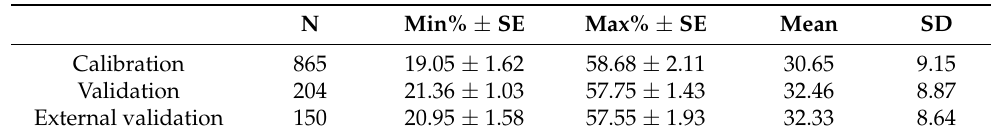
Table 1. Sample parameter values of amylose content used in calibration, validation and external validation derived from chemical measurements.